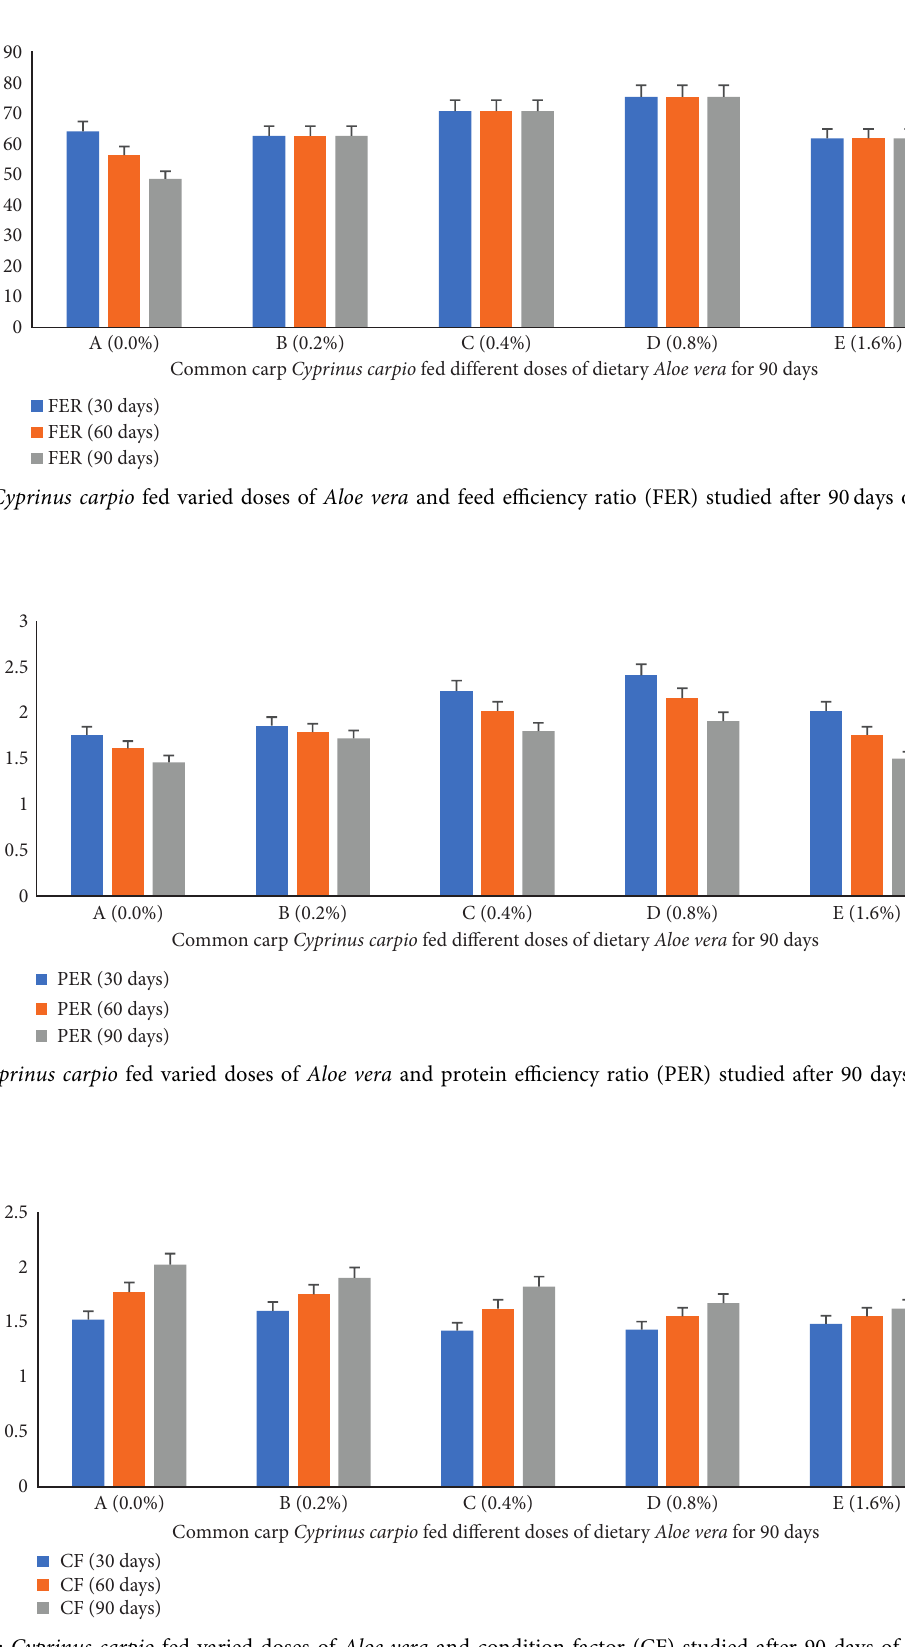
Figure 6: Cyprinus carpio fed varied doses of Aloe vera and condition factor (CF) studied after 90 days of feeding trial.